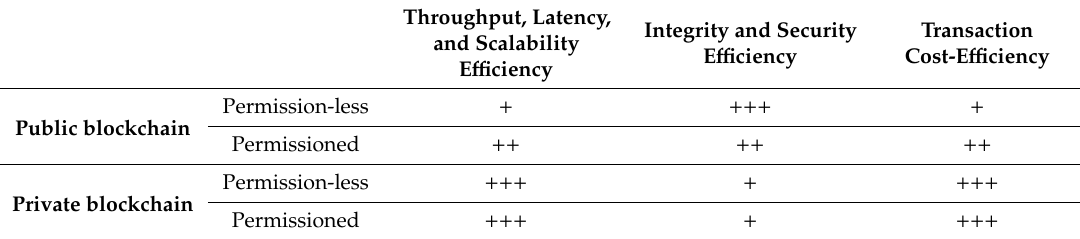
Table 1. The level of decentralisation and blockchain properties (adopted from Reference [43]).